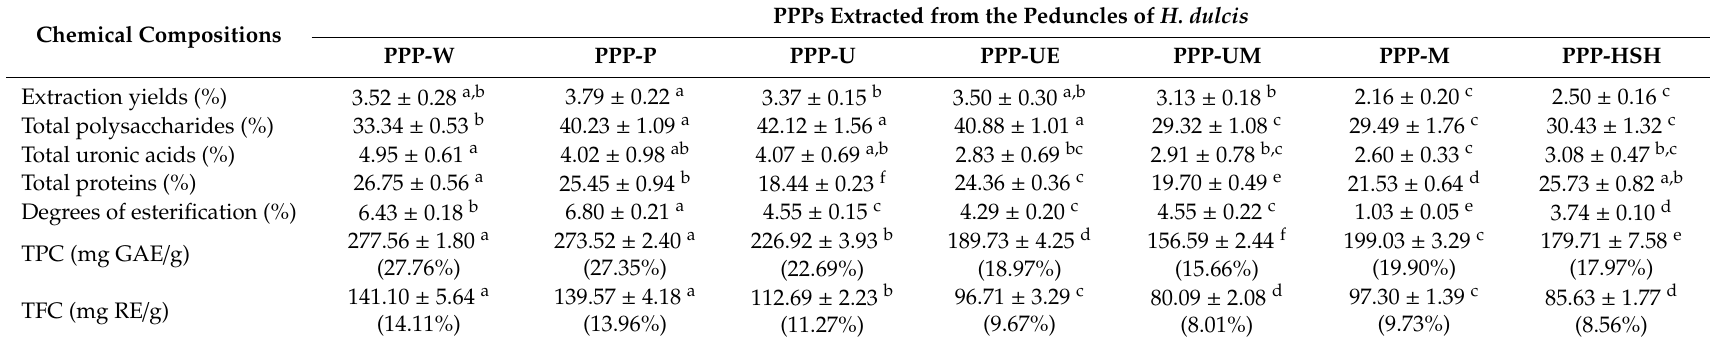
Table 1. Chemical compositions of PPPs obtained by seven extraction